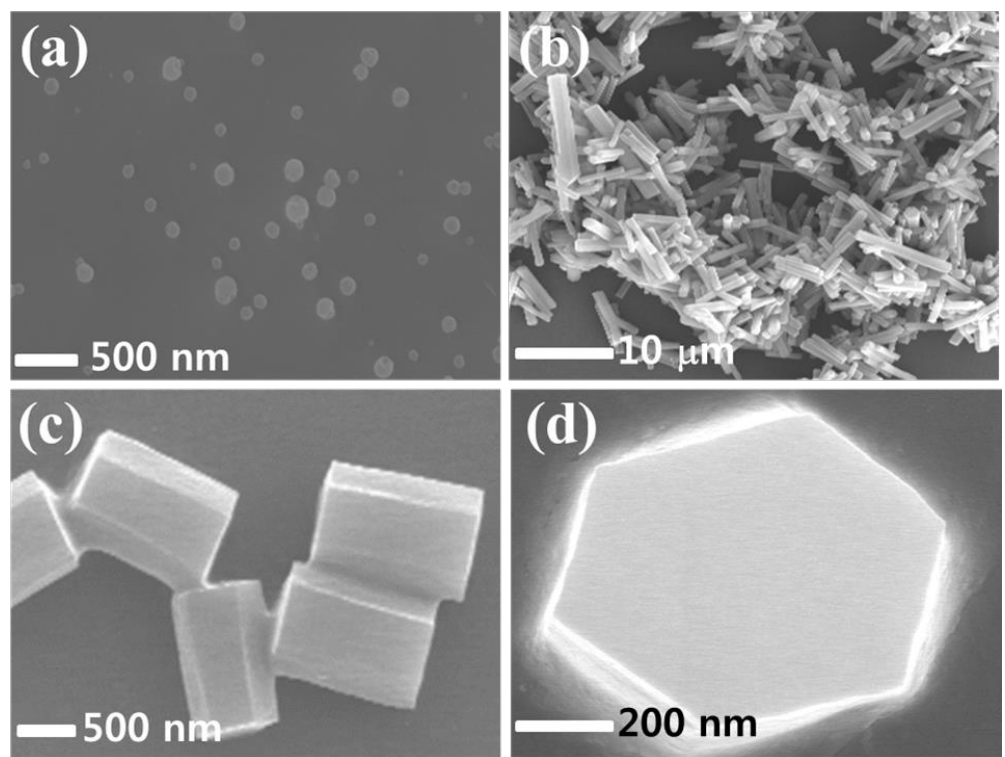
Figure 2. Scanning electron microscopy (SEM) images of ( a ) Alq 3 NPs and ( b ) crystalline hexagonal columns of Alq 3 . High-magnification SEM images of ( c ) side view and ( d ) top-view of crystal hexagonal columns of Alq 3 .